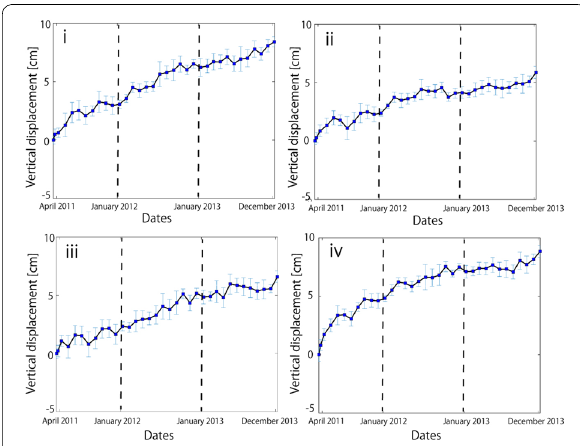
Fig. 4 Time series of vertical surface displacement during April 2011 to December 2013 at selected GPS stations. The locations of ( i )–( iv ) are in Fig. 3b1. Dashed lines indicate the boundaries of the period used to calculate the annual